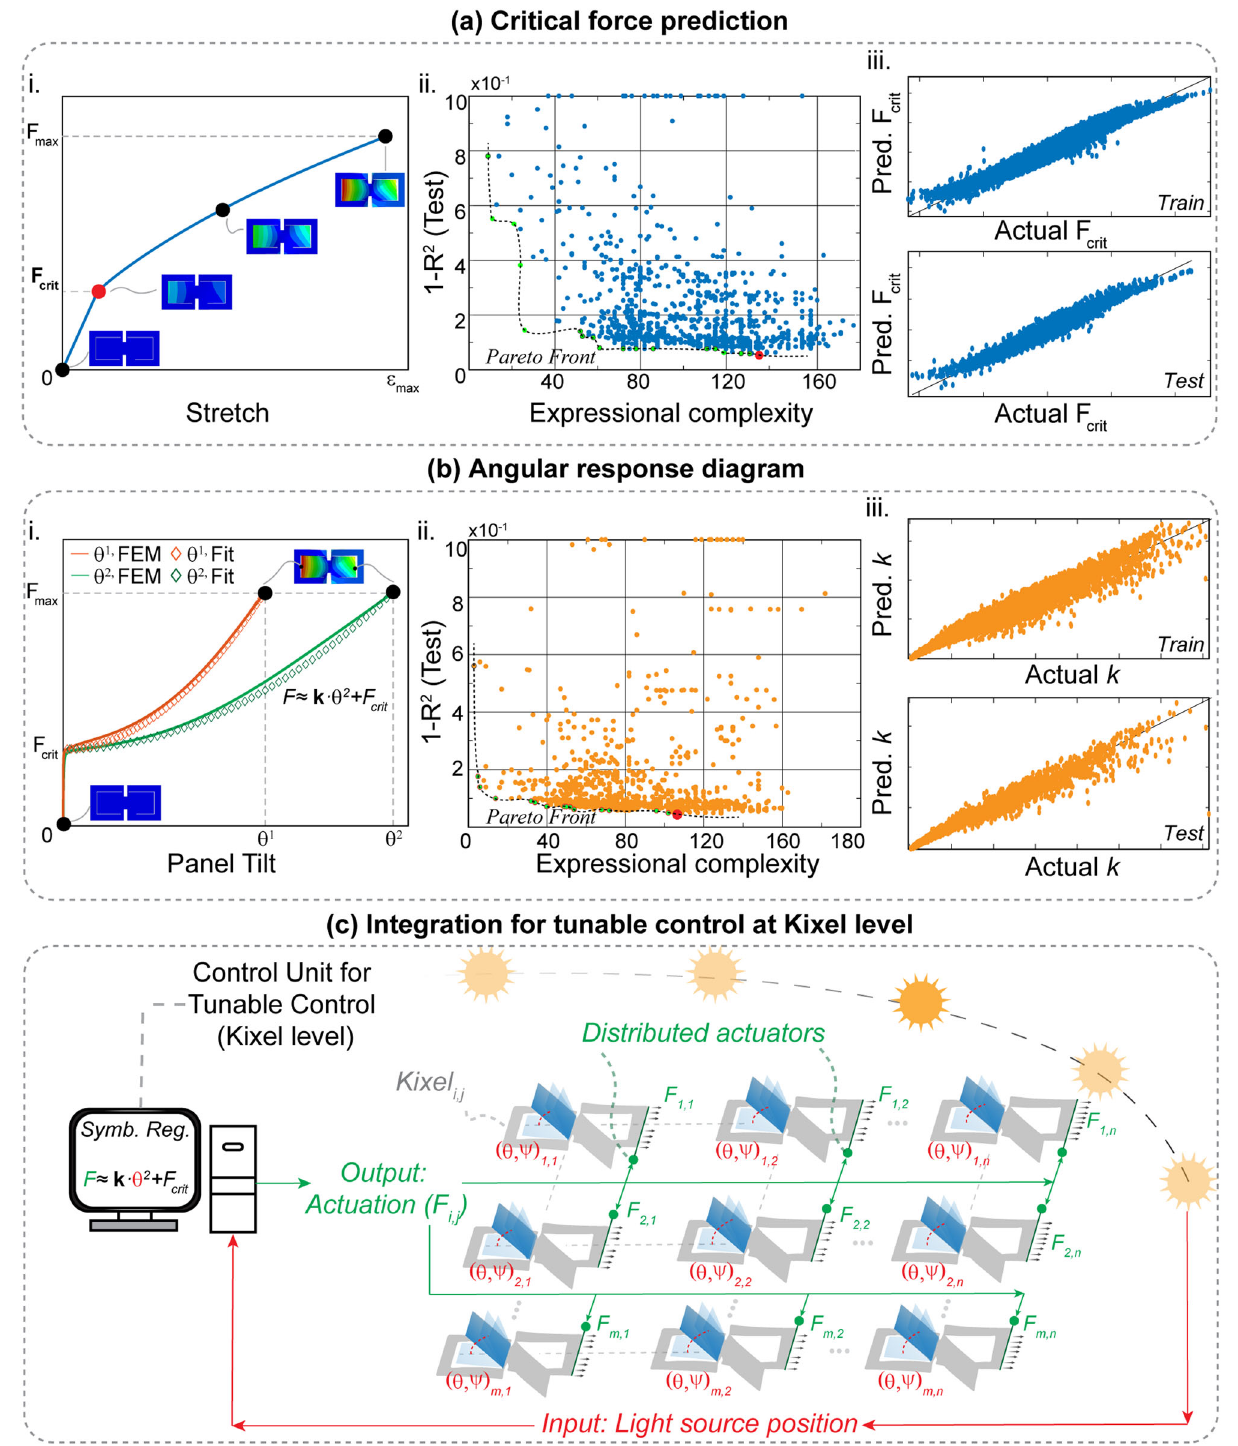
Fig. 5 Symbolic regression for control of inversely designed Kirigami meta-atoms. a SR applied to structural response of Kirigami: (i) Force- displacement relationship, (ii) Accuracy vs. complexity of parsimonious mode with pareto front de fi ned by green points, (iii) Predicted vs. actual critical force for training and test set. b SR applied to structural response of each panel: (i) FEM and fi tted bifurcation curves, (ii) Accuracy vs. complexity of parsimonious mode with pareto front de fi ned by green points, (iii) Predicted vs. actual fi tting constant k for training and test sets. c Schematic diagram for application of the symbolic regression framework for tunable control of Kirigami units with distributed